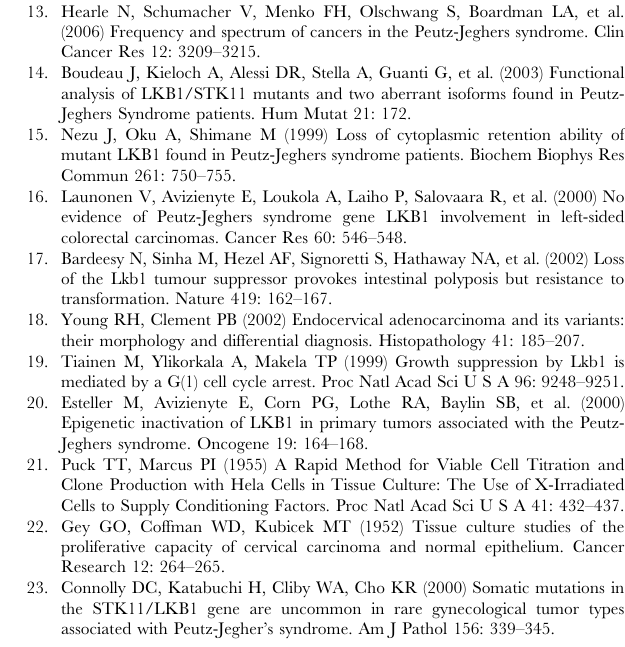
Table S1 Complete list of LKB1 mutations detected by sequencing or